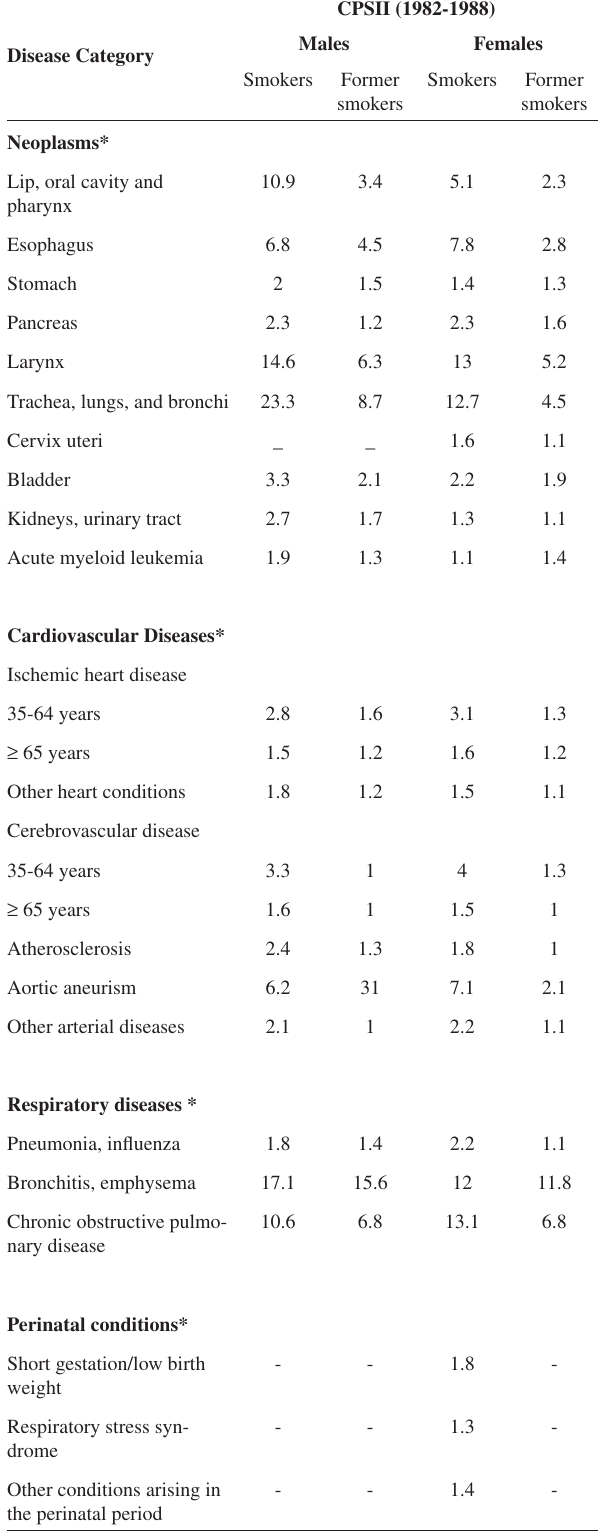
Figure 1 - Relative risks of the main tobacco-related diseases used in the Global Burden of Disease Survey. Rio de Janeiro State, Brazil,